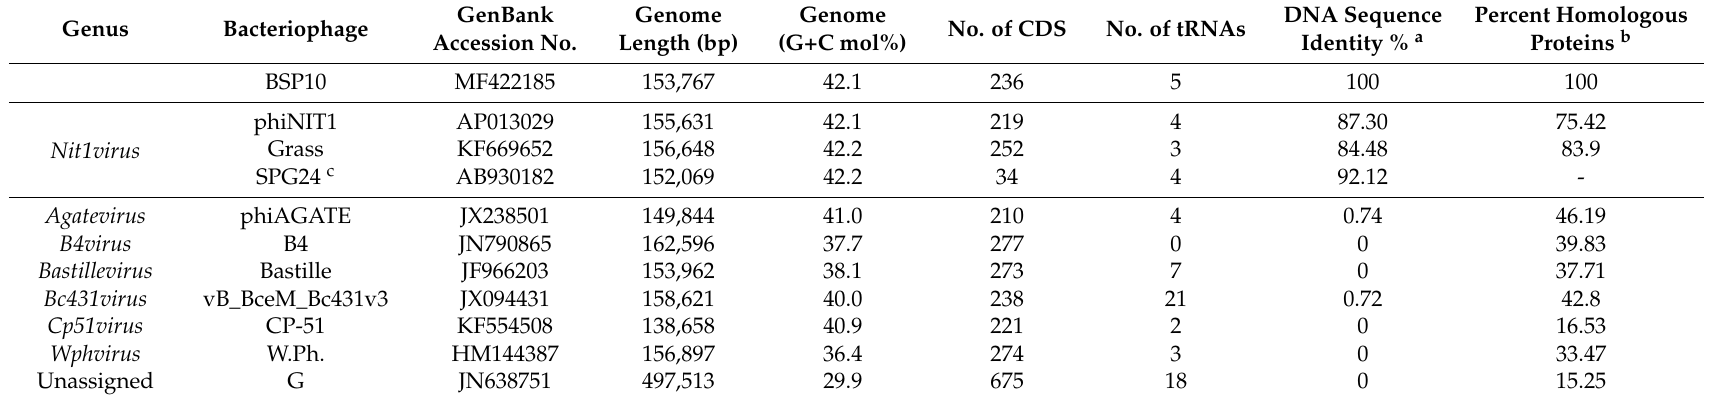
Table 1. Genomic and proteomic features of ICTV-classified Bacillus bacteriophages and bacteriophage